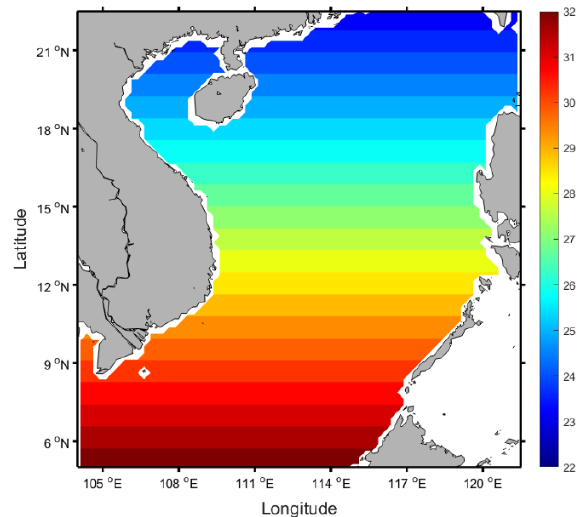
Figure 4. The estimated background SST distribution (unit: °C).